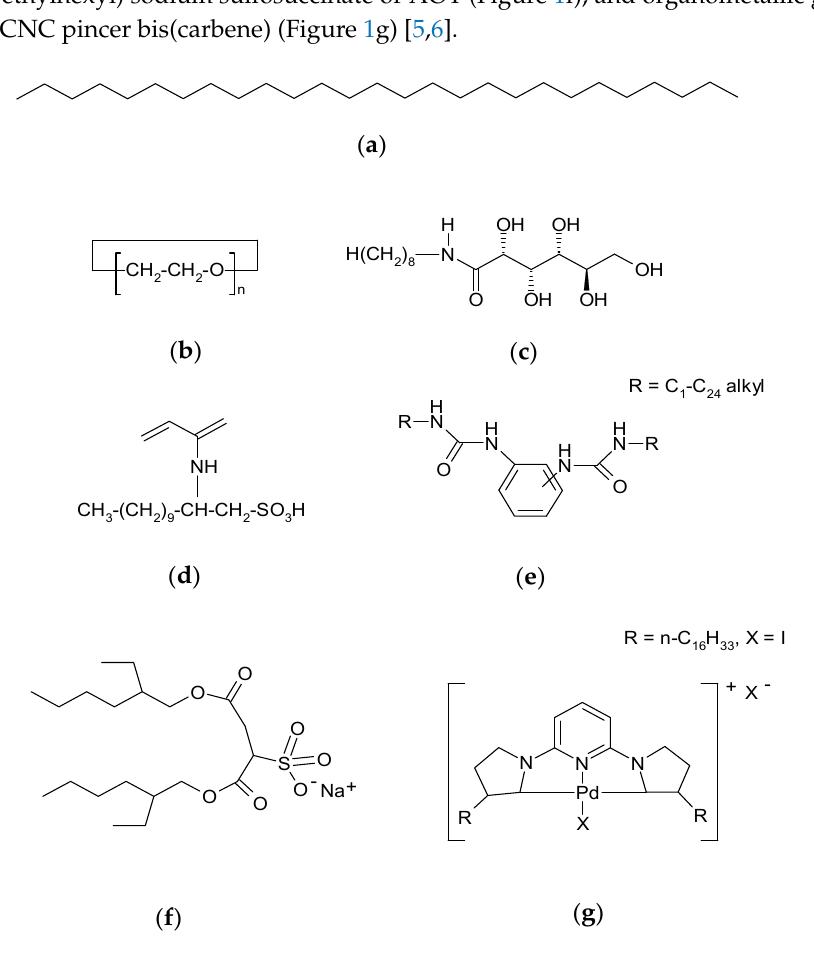
Figure 1. Examples of LMOG chemical structure: ( a ) n-octacosane; ( b ) 60-crown-20-macrocycle; ( c ) N -n-octyl- D -gluconamide; ( d ) 2-acryloylamide-dedecane-1-sulfonic acid (ADSA); ( e ) cyclic bis-urea gelator; ( f ) bis-(2-ethylhexyl) sodium sulfosuccinate (AOT); ( g ) palladium-CNC pincer bis(carbene).